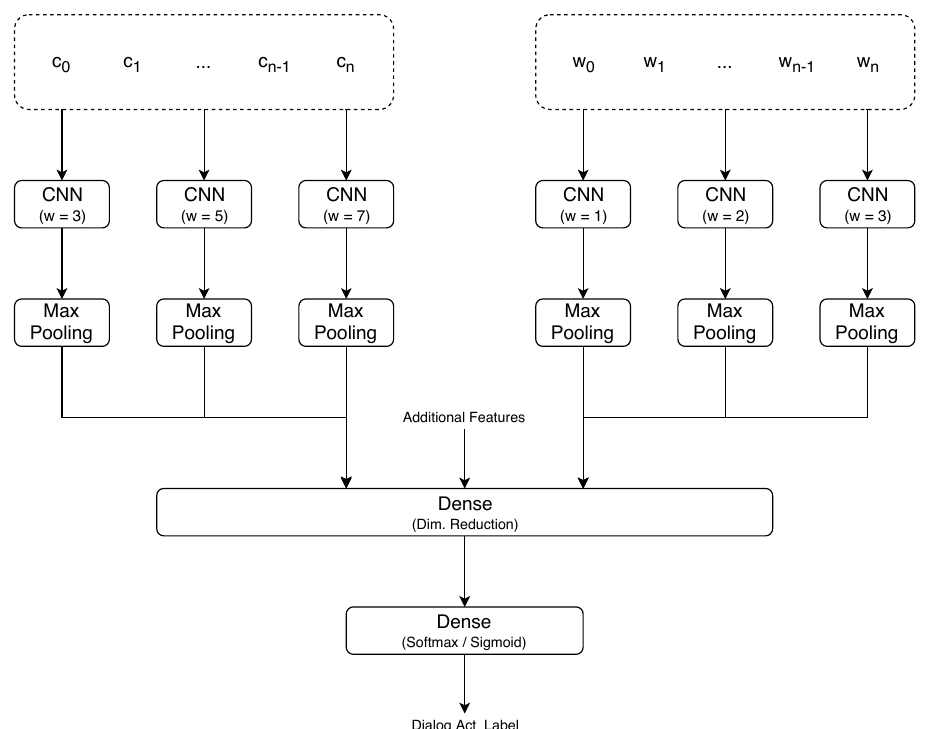
Figure 2. The architecture of the network that combines the character- and word-level approaches. c i corresponds to the embedding representation of the i th character while w i corresponds to the embedding representation of the i th word. The context window sizes of the CNNs in the character-level branch refer to those that achieved best performance in our experiments. Those in the word-level branch correspond to the ones used by Liu et al. [6] in their